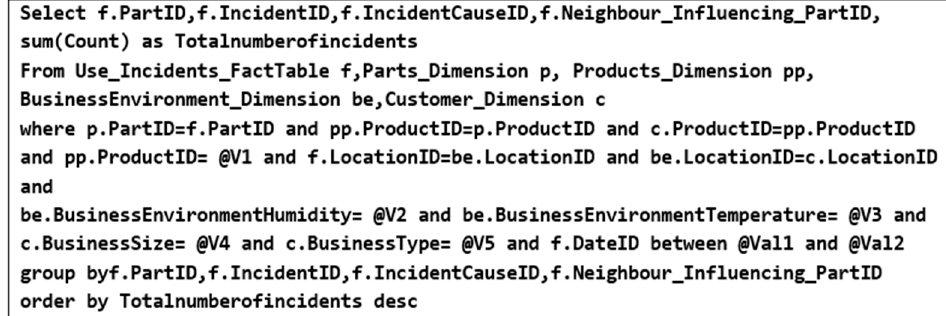
Figure 4. SQL query for retrieving the number of incidents on each product’s part.